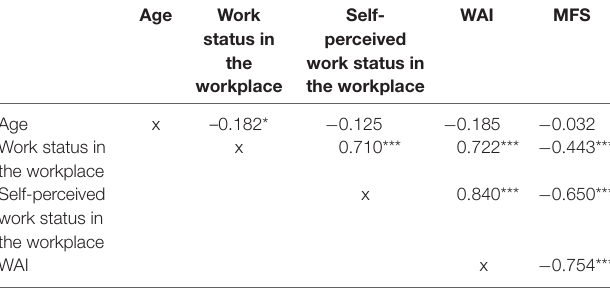
TABLE 4 | Correlation between age, work status in the workplace, self-perceived work status in the workplace, WAI (Work Ability Index), MFS (Mental Fatigue Scale), r , and p